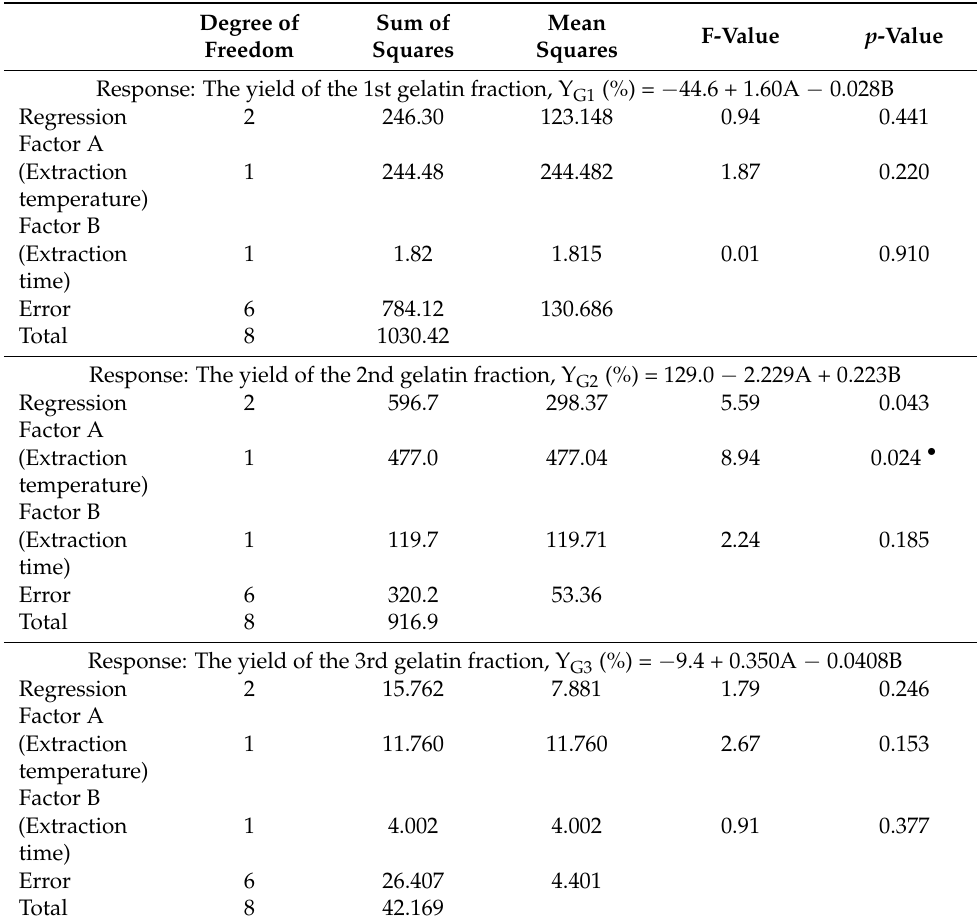
Table 2. Analysis of variance of the experimental design for gelatin yields.